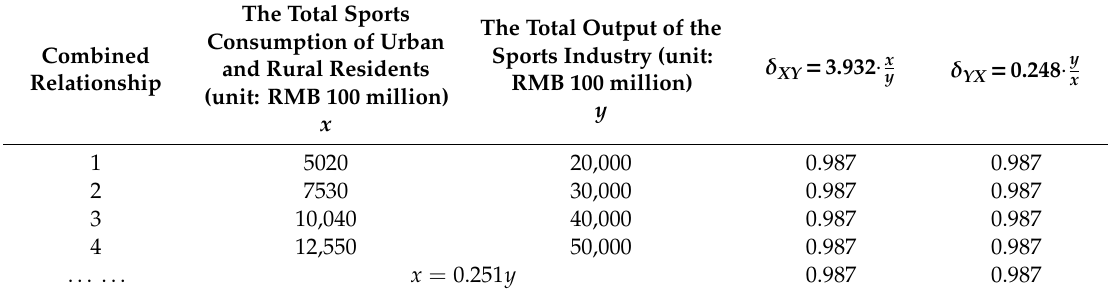
Table 5. Examples of symmetric reciprocal symbiosis combined relationship between NF and